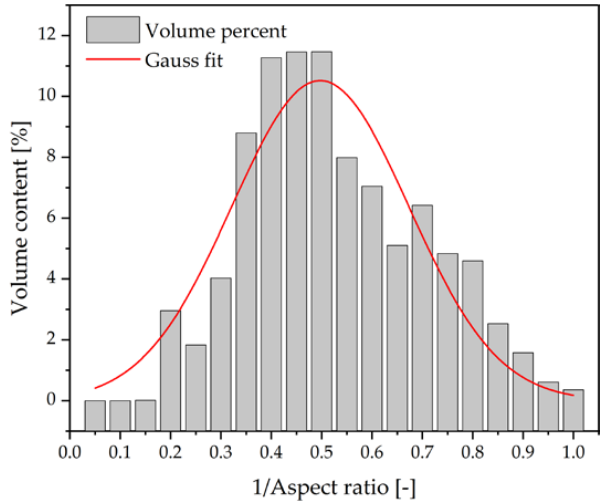
Figure 5. Measured distribution of aspect ratio of Silatherm 1360-007.